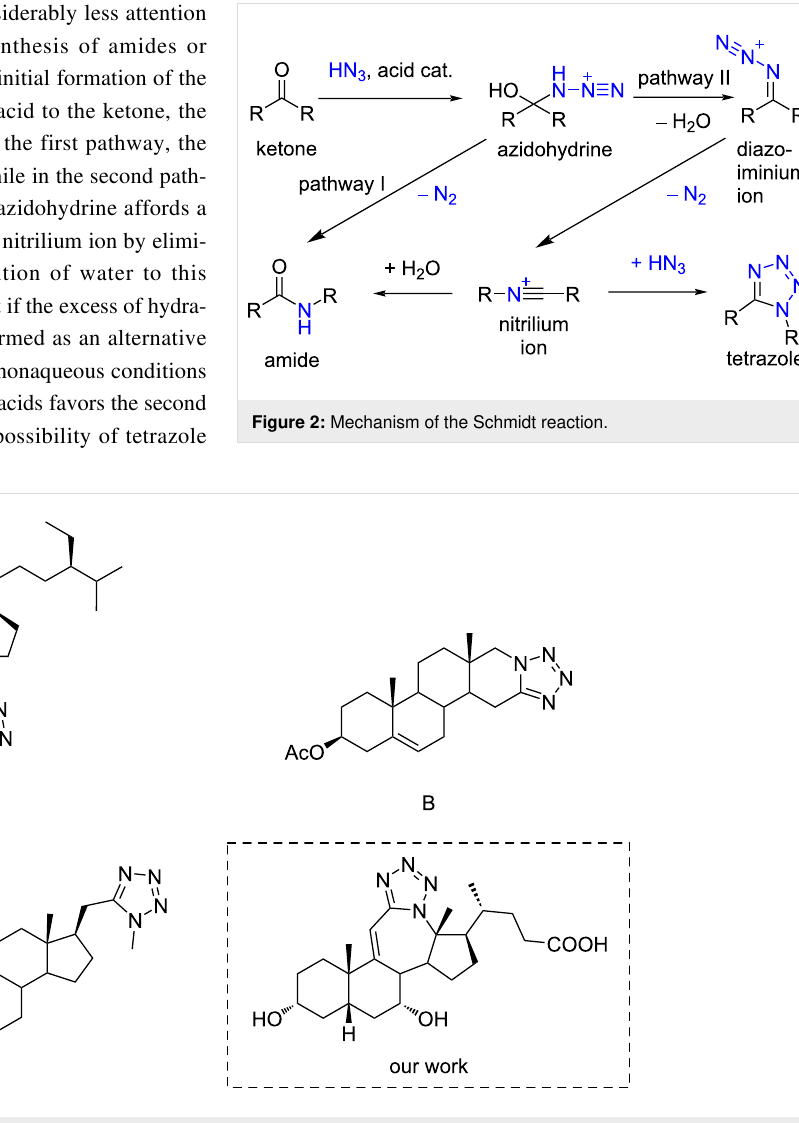
Figure 1: Structures of the steroidal tetrazoles that showed anticancer potential in vitro.